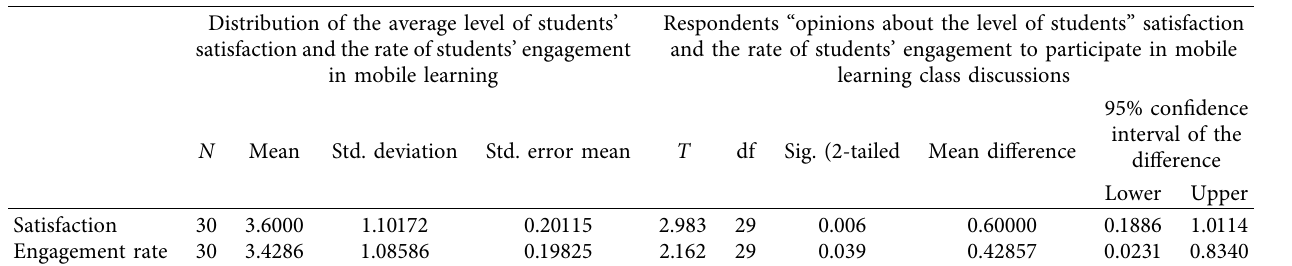
Table 4: Descriptive and inferential